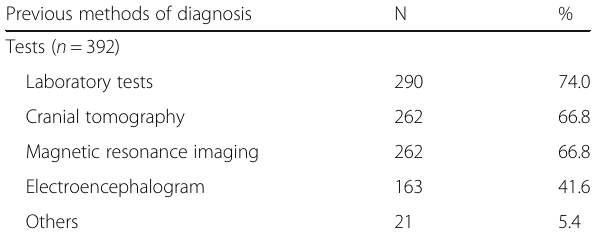
Table 3 Previous methods of diagnosis reported by